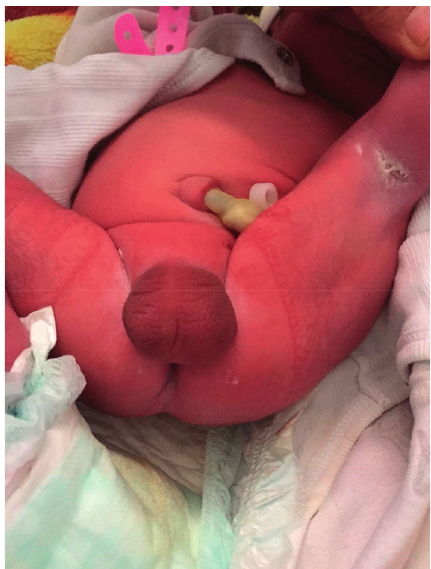
Figure 2: The anal opening is located normally.